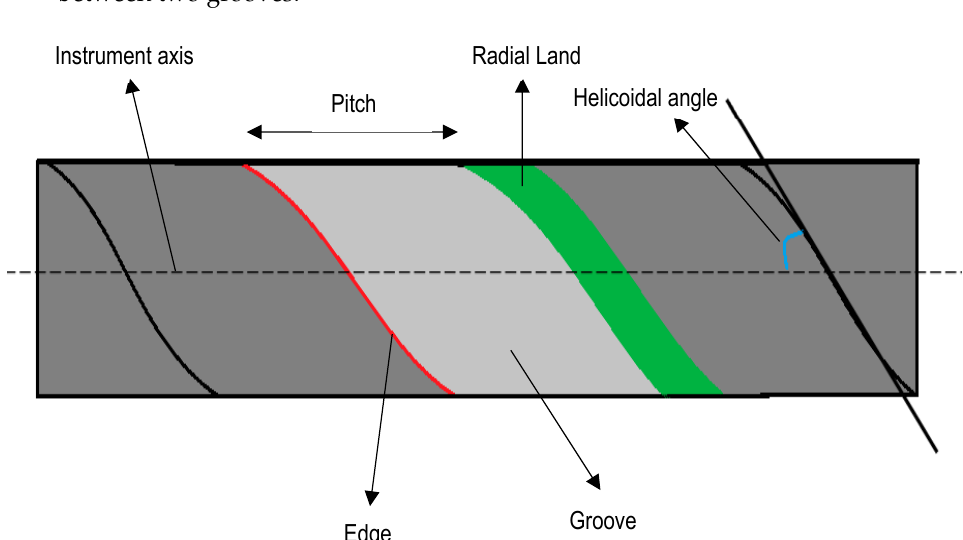
Figure 2. Parts of rotary file.